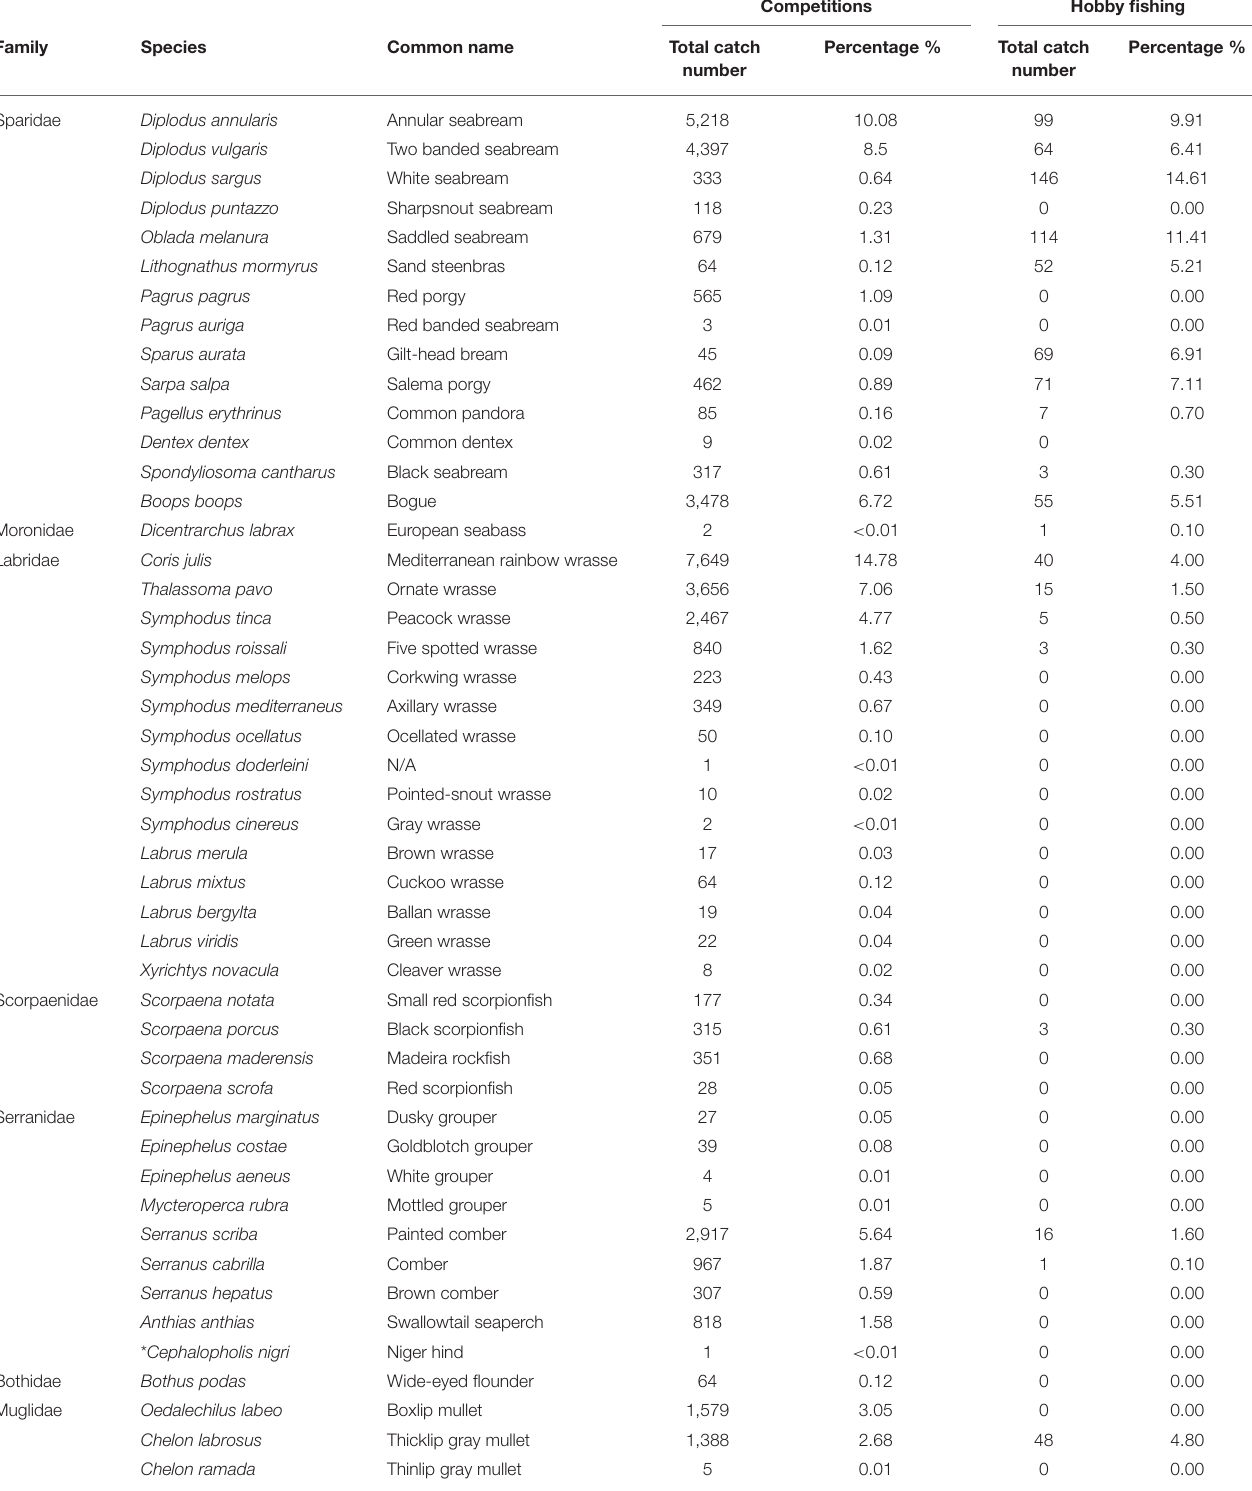
TABLE 4 | Total catch number and percentage of species caught during fishing competitions and by hobby fishers in this case